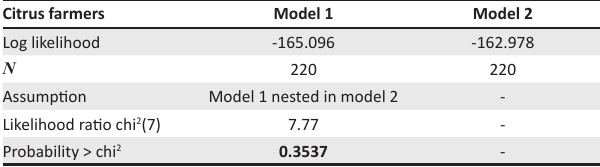
TABLE 3: Likelihood ratio test of hypothesis for profit efficiency